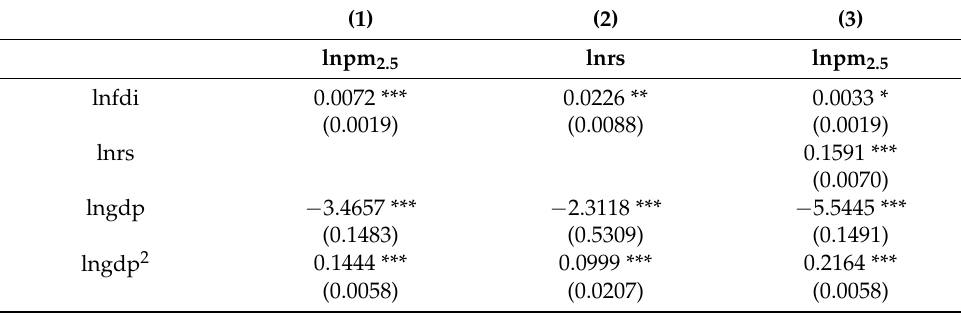
Table 9. Mediating effect of the industrial structure rationalization